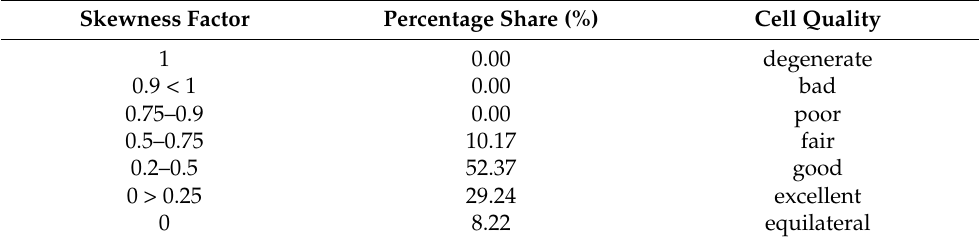
Table 1. Percentage share of numerical grid cells for skewness factor ranges. Skewness